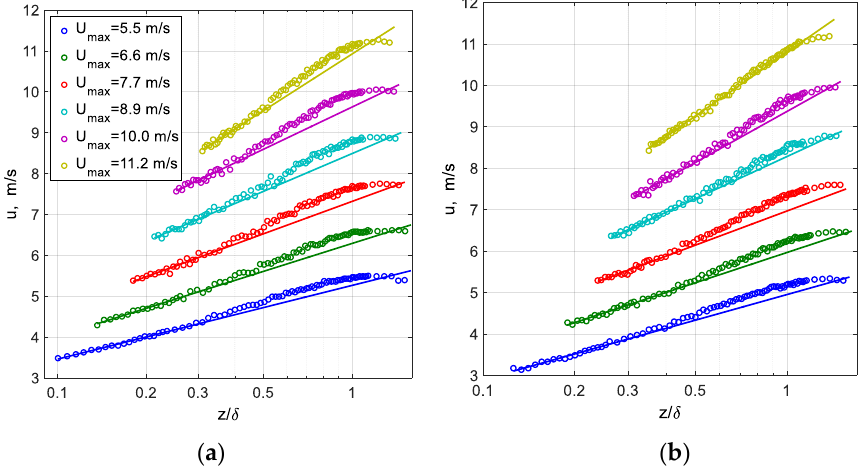
Figure 2. Vertical profiles of the mean air velocity and the logarithmic fits performed for locations satisfying z / δ < 0.4 (solid lines): ( a ) x = 260 cm; ( b ) x = 340 cm.